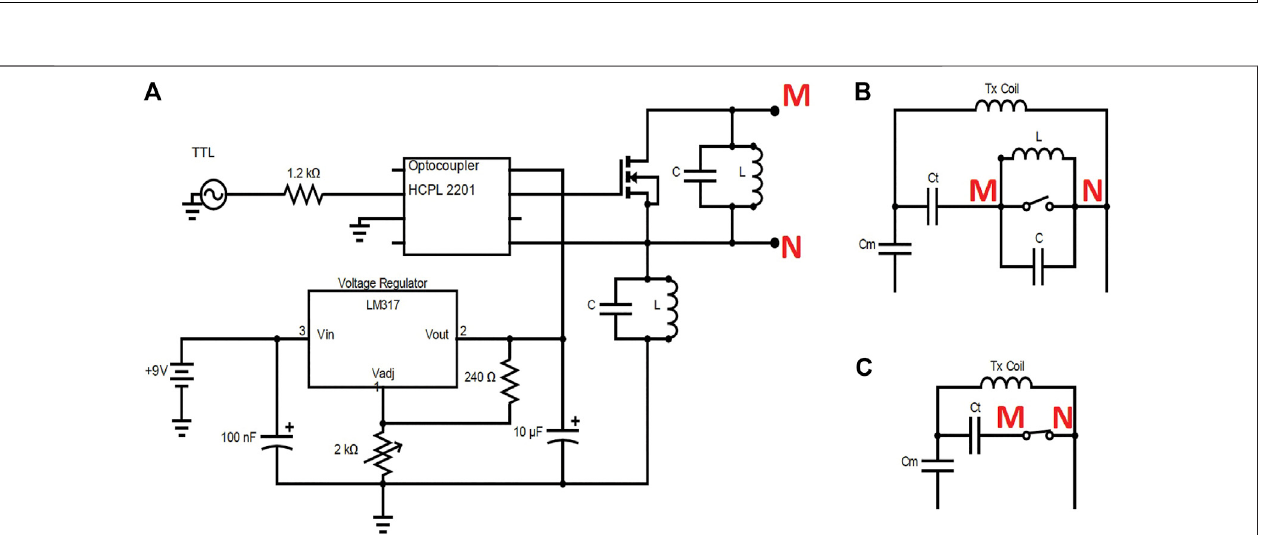
FIGURE 5 | The MOSFET switch circuit (A) , and Tx coil impedance matching circuit when switch is on (B) and off (C) . Note that when the TTL signal is on, the switch is off, and vice-versa.